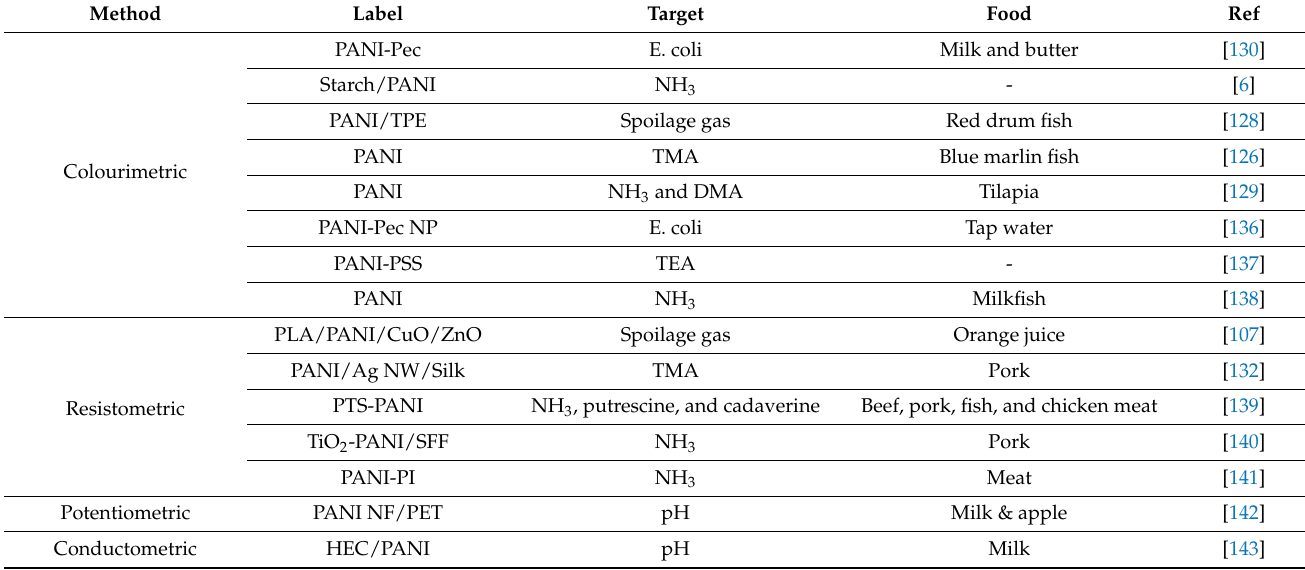
Table 3. Applications of PANI as a food freshness